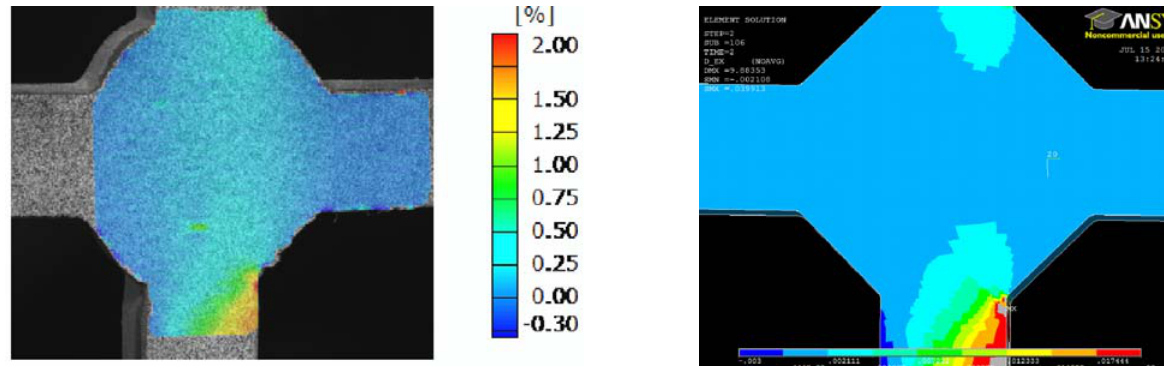
Figure 21: DIC vs FE values of Δ ε x